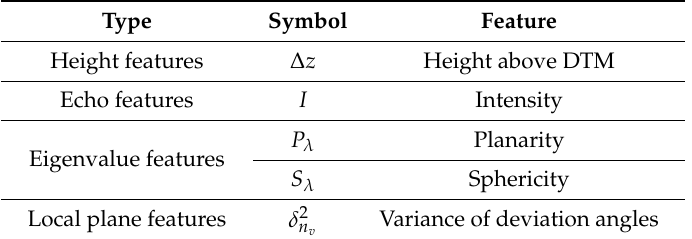
Table 1. LiDAR features for